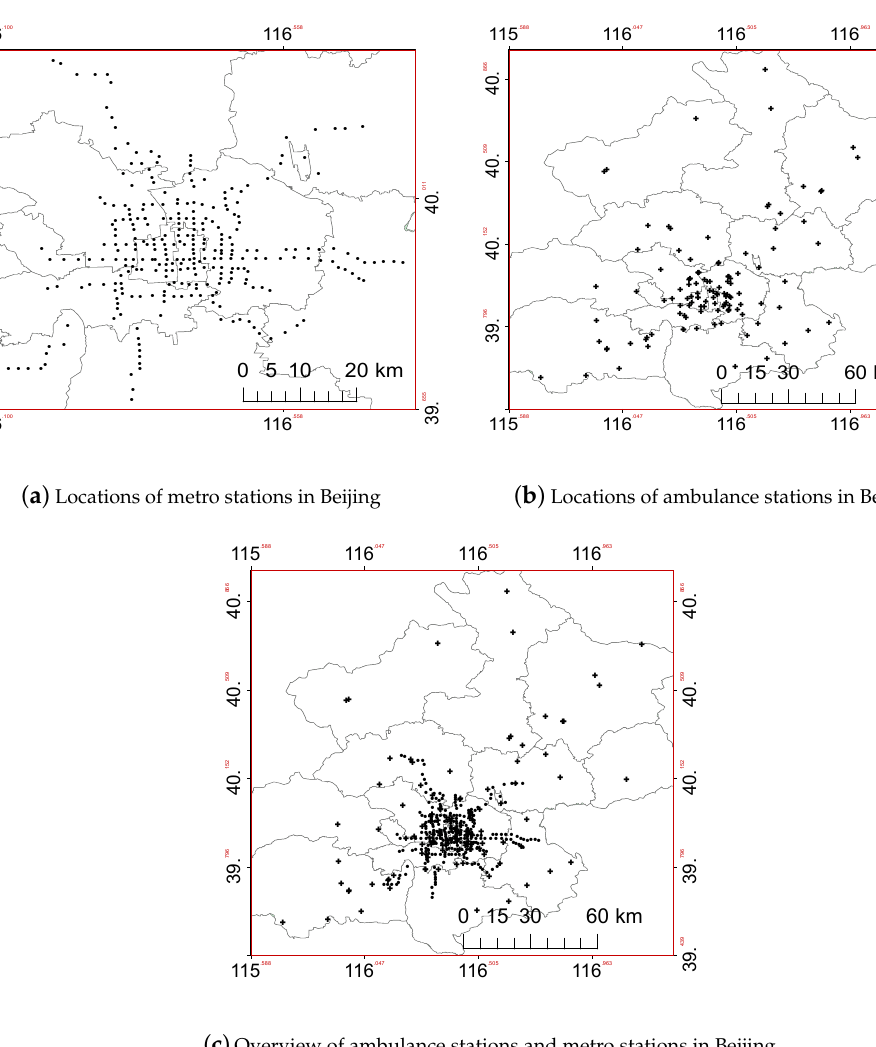
( c ) Overview of ambulance stations and metro stations in Beijing Figure 2. Location